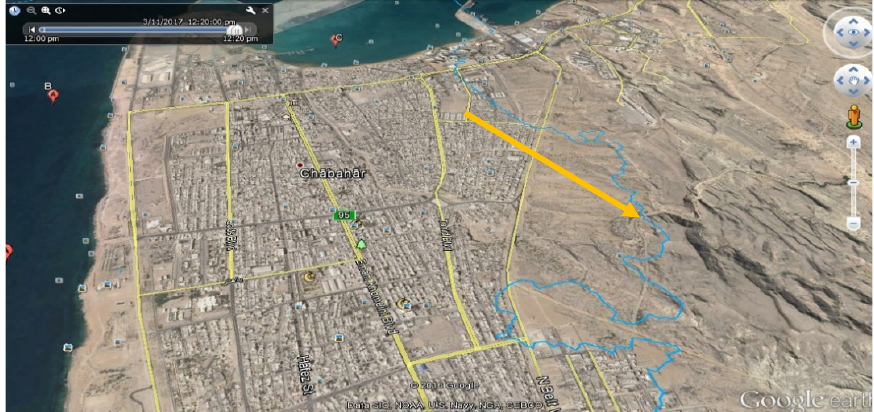
Figure 8. Chabahar port region, blue line shows the coastal line during the tsunami simulation. This photo shows 20 minutes after the tsunami generation. Figure 9, represent flowchart of the transformation of PNG raster to KML using of FME. Figure 10. Represents the worst case scenario inundating tsunami wave for 18 minutes and 20 seconds after the tsunami generation time.